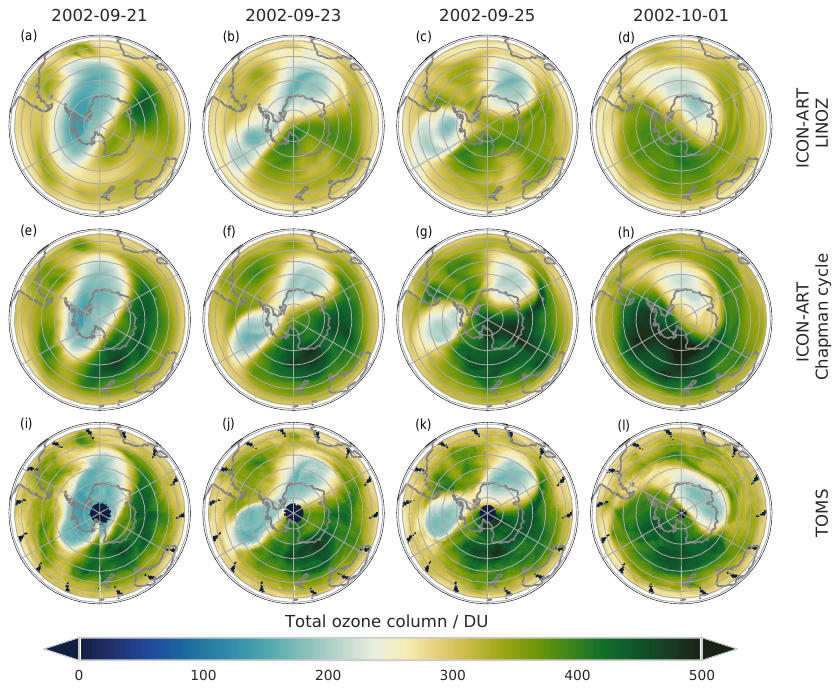
Figure 3. Antarctic total ozone column (DU) for a time sequence starting on 21 September 2002 finishing 1 October 2002 (left to right). Daily averages for two ICON-ART simulations for the Linoz chemistry scheme (a–d) and for the extended Chapman cycle chemistry (e–h) . Total Ozone Mapping Spectrometer (TOMS) observations are shown in panels (i–l) . The model was initialised on 20 September